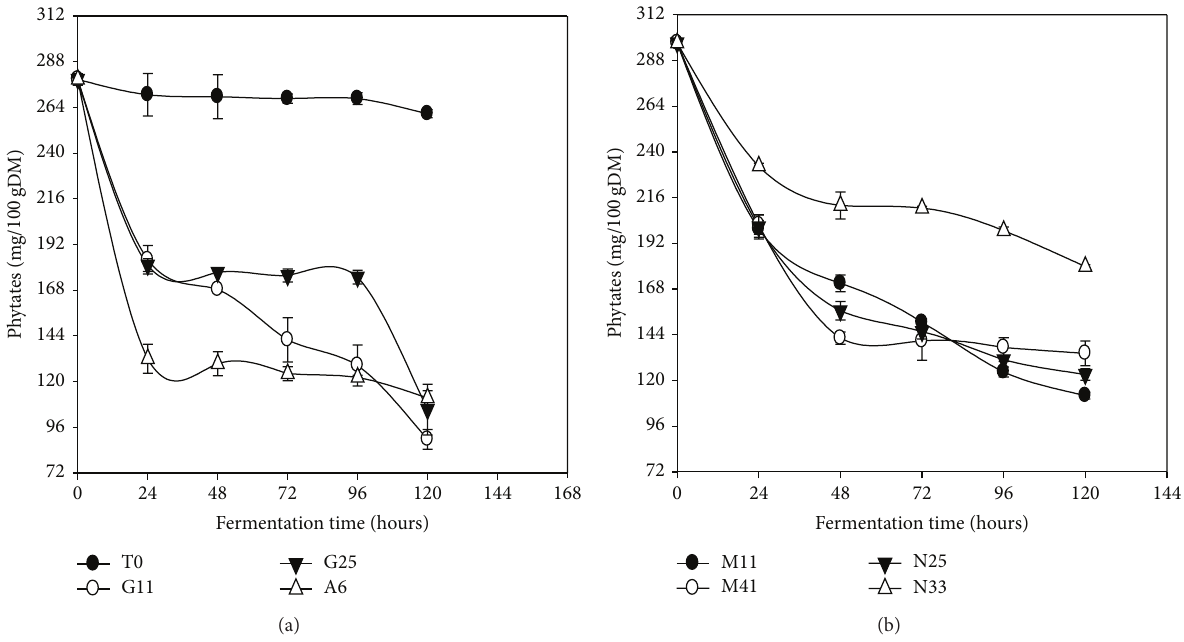
Figure 8: Evolution of phytates content in Kutukutu during fermentation by the various LAB at 25 ∘ C (T0 = control; G11 = L. brevis G11; G25 = L. brevis G25; A6 = L. plantarum A6; M11 = L. buchneri M1; M41 = L. cellobiosus M41; N33 = L. fermentum N33; N25 = L. fermentum N25).